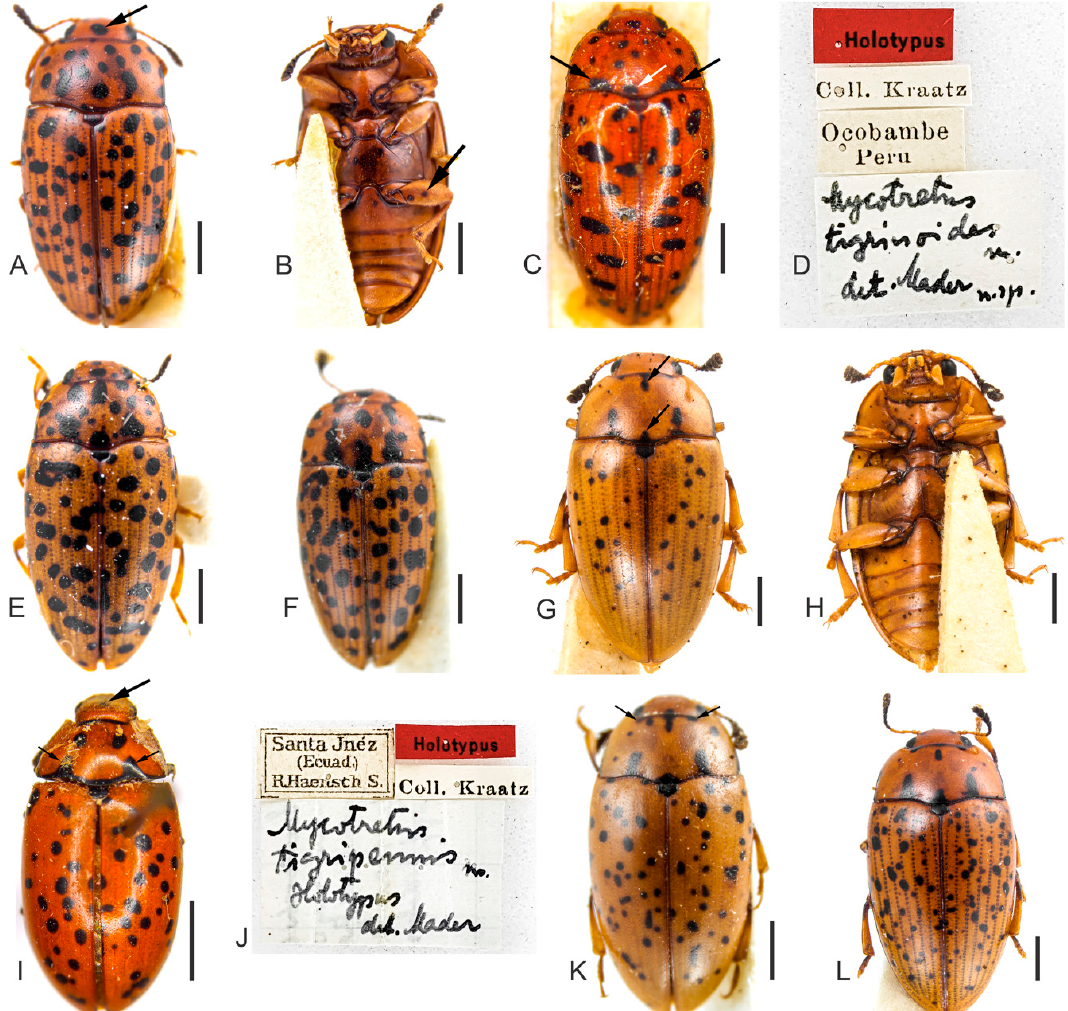
Figure 7. ( A – F ) Specimens of Mycotretus tigrinoides Mader, 1942 from different localities: ( A – B ) male, dorsal and ventral view, respectively (Tucuruí, PA, Brazil): ( A ) arrow showing the major black spot on the disc of head, ( B ) arrow showing a subcircular spot on metafemur. ( C – D ) Holotype (Ocobamba, Peru): ( C ) dorsal view, black arrows showing the two lateral spots on the basal pronotal edge and white arrow showing the inner spot. ( D ) Labels. ( E ) Female (Brasília, DF, Brazil); ( F ) male (Sinop, MT, Brazil). ( G – L ) Specimens of Mycotretus tigripennis Mader, 1942 from different localities: ( G – H ) male, dorsal and ventral view, respectively (Piraí, Reprêsa Rio Grande, RJ, Brazil): ( G ) arrows showing elongated and medial spots between two lateral tooth-like spots on pronotum. ( I – J ) Holotype (Santa Inéz, Ecuador): ( I ) big arrow showing one black spot on the disc of head, small arrows showing two lateral tooth-like spots on basal pronotal edge. ( J ) Labels. ( K ) Female (Piraí, Reprêsa Rio Grande, RJ, Brazil), arrows showing two lateral tooth-like spots on anterior pronotal edge. ( L ) Female (Piraí, Reprêsa Rio Grande, RJ, Brazil). Scale bars: A – C , E – H , K – L = 1 mm; I = 2 mm. Redescription . Length (in mm) = 3.95–5.46 (4.85 ± 0.51, n = 13). Very similar to M. tigripennis . Body elongate, subparallel-sided, widest at the anterior third of elytra, TL/EW = 1.80–1.91 (1.86 ± 0.03), glabrous and glossy; dorsal and ventral coloration (Figure 7A–F) reddish-brown, with mouthparts and first antennomeres yellowish to reddish-brown; legs yellowish to reddish-brown with coxae and tibiae partially blackish in some individuals; mandible apices and last antennomeres blackish; mentum plate pentagonal, with strongly sclerotized margin. Venter usually with black and subcircular spots on prosternum, meso- and meta-ventrite, abdomen and legs (Figure 7B, arrow). Scutellar